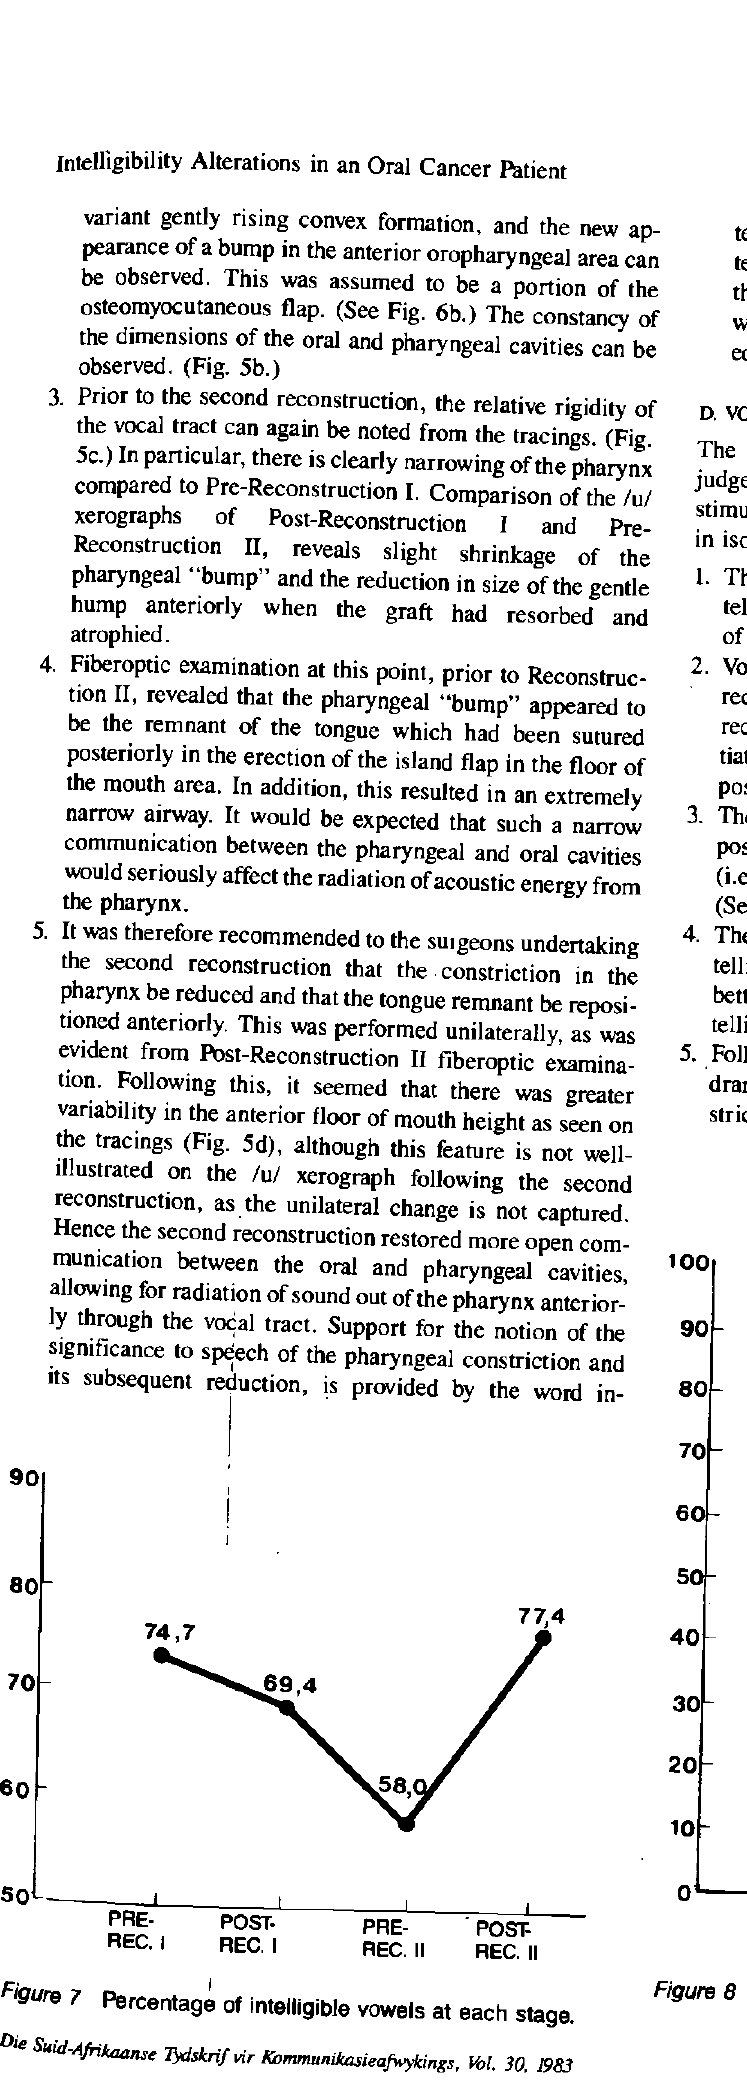
Figure 8 Percentage of individual vowel intelligibility at each